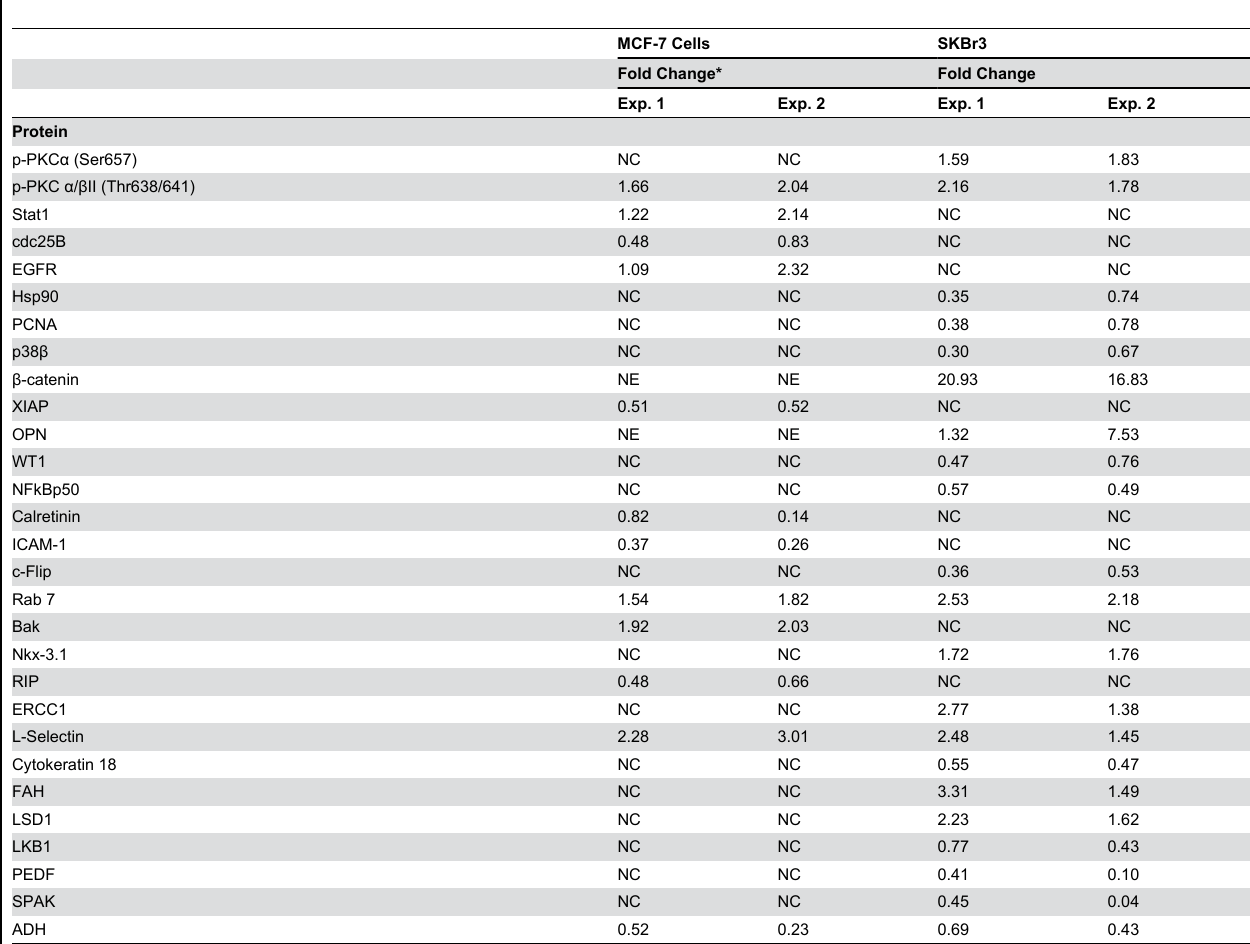
Table 9. PPAA analysis of pathway protein expression as a function of ACSL4 expression.